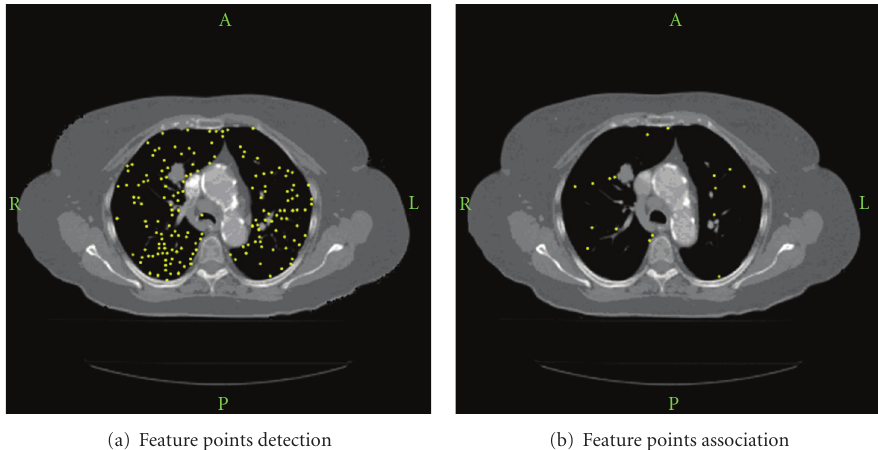
Figure 7: An example of feature points detection and